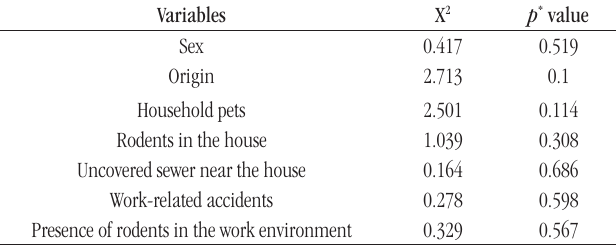
taBLE 2 − Values of the chi-square test for sociodemographic, epidemiological and labor variables of interest in the transmission of Leptospira spp.